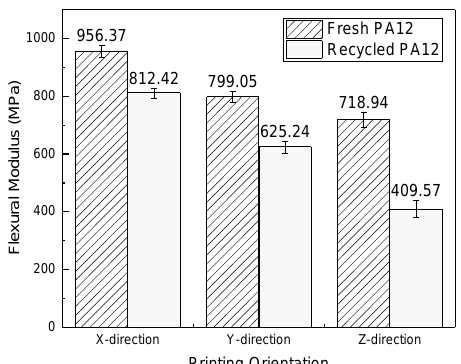
Figure 5. Flexural modulus of test samples in different printing orientations.